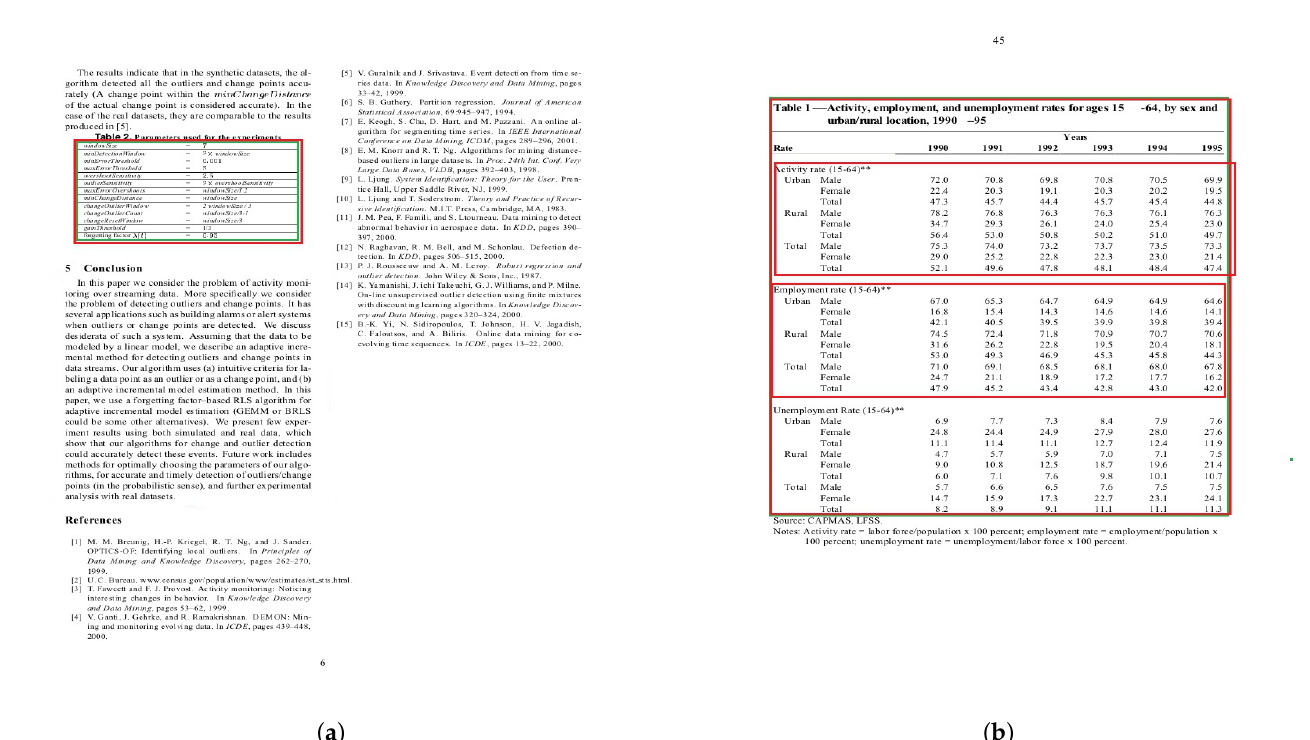
Figure 11. Some sample images from Marmot showing: ( a ) true positive and ( b ) false positive. The green region represents the ground truth bounding boxes while red region represents bounding boxes of detected regions.